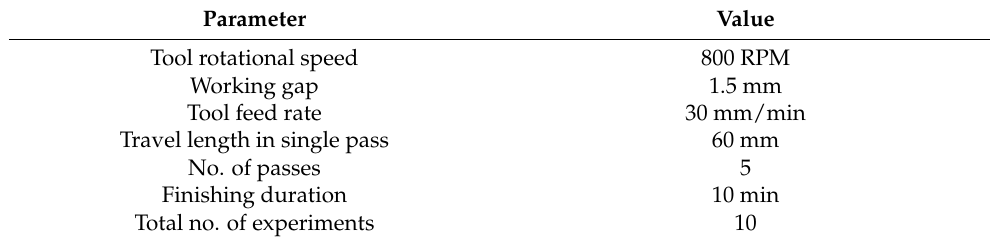
Table 3. The details of the finishing experiment.